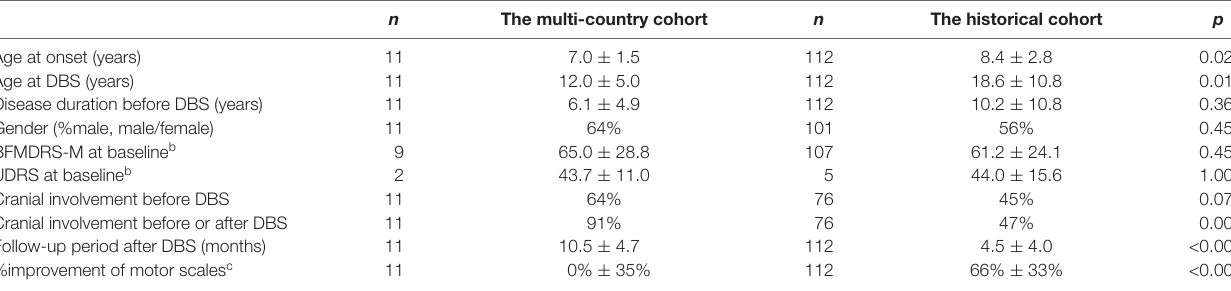
Data are presented as mean ± SD unless otherwise indicated. a P < 0.05 (significant). b Motor assessments were done using either BFMDRS-M or UDRS. c % improvement at the last follow-up compared with the preoperative scores. BFMDRS-M, Burke-Fahn-Marsden Dystonia Rating Scale motor score; DBS, deep brain stimulation; UDRS, Unified Dystonia Rating